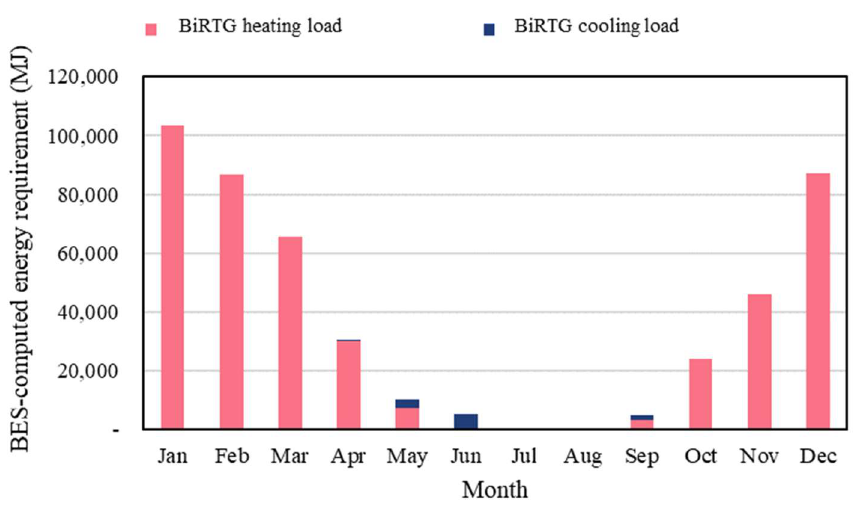
Figure 13. Monthly heating and cooling energy loads in a rooftop greenhouse with crop.